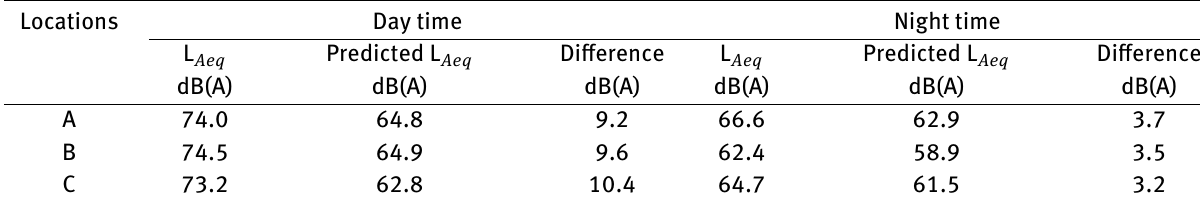
Table 2: Difference between Measured L Aeq and Predicted L Aeq − SoundPLAN (Central zone)